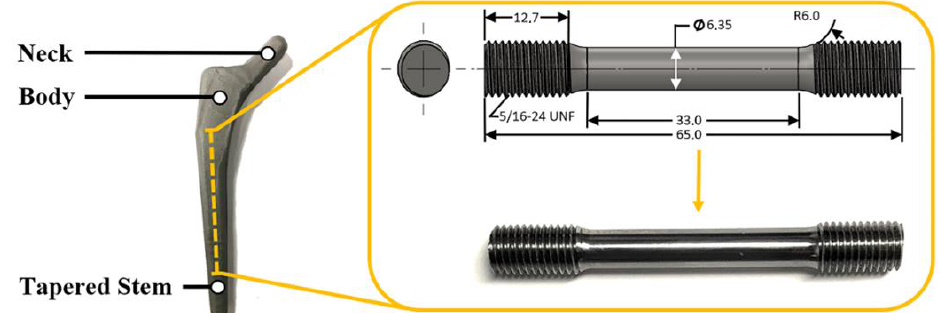
Figure 5. Detail view of the tensile bar and sampling locations for hardness, micrographs and tensile specimens.